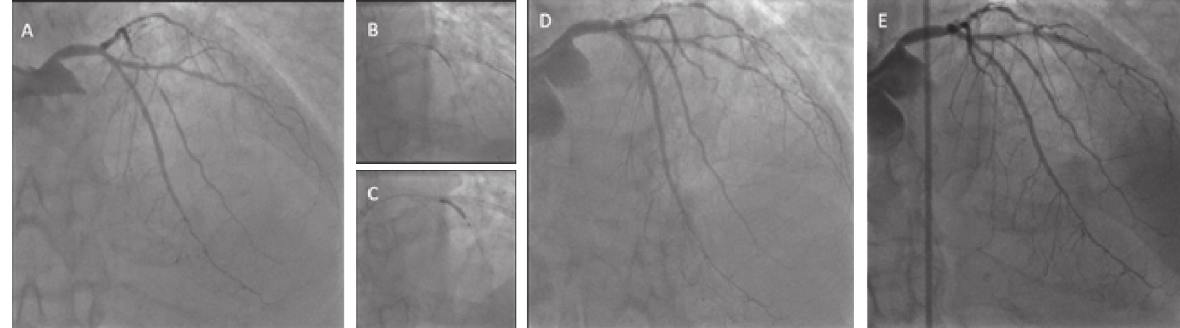
Figure 3: NSTEMI patient undergoing OCT-guided PCI with the SCB of ostial ISR on RCA. A patient with NSTEMI showing significant stenoses of the distal RCA with significant ISR at the ostium (a). All lesions were predilated with a 2.0 × 20 noncompliant balloon ((b) and (c)). A linear dissection became evident in the distal segment (d) and was covered with a 2.25 × 35mm DES (e) postdilated with a noncompliant 2.5 × 12mm balloon (f). The OCT pullback of the ostial ISR revealed a typical fibrotic pattern of neointimal hyperplasia causing significant restenosis (g). The lesion was treated with several inflations of a 3.5 × 15mm noncompliant balloon at high atmospheres (h) and with a 3.5 × 15mm SCB afterward (i). Final OCTpullback (j) showed a significant improvement of the MSA with a small neointimal dissection (see asterisk).